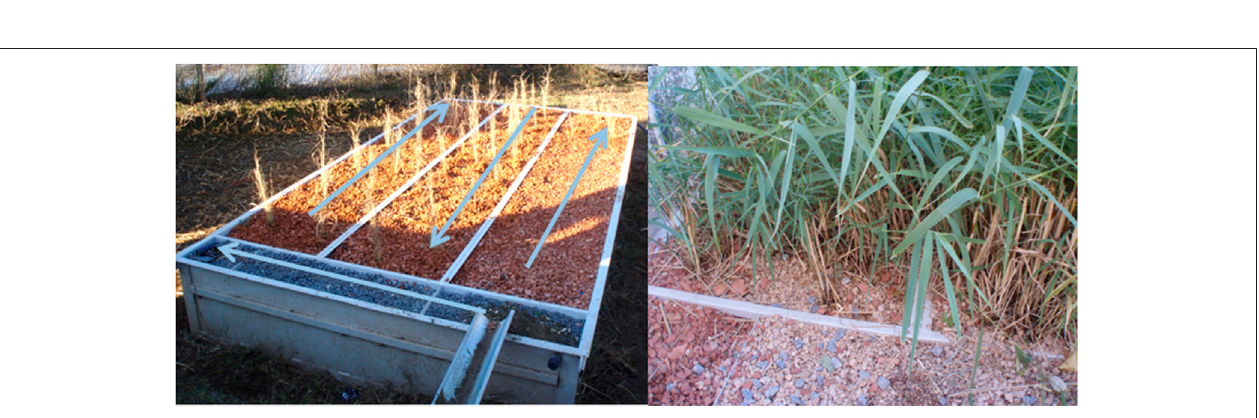
Frontiers in Environmental Science |